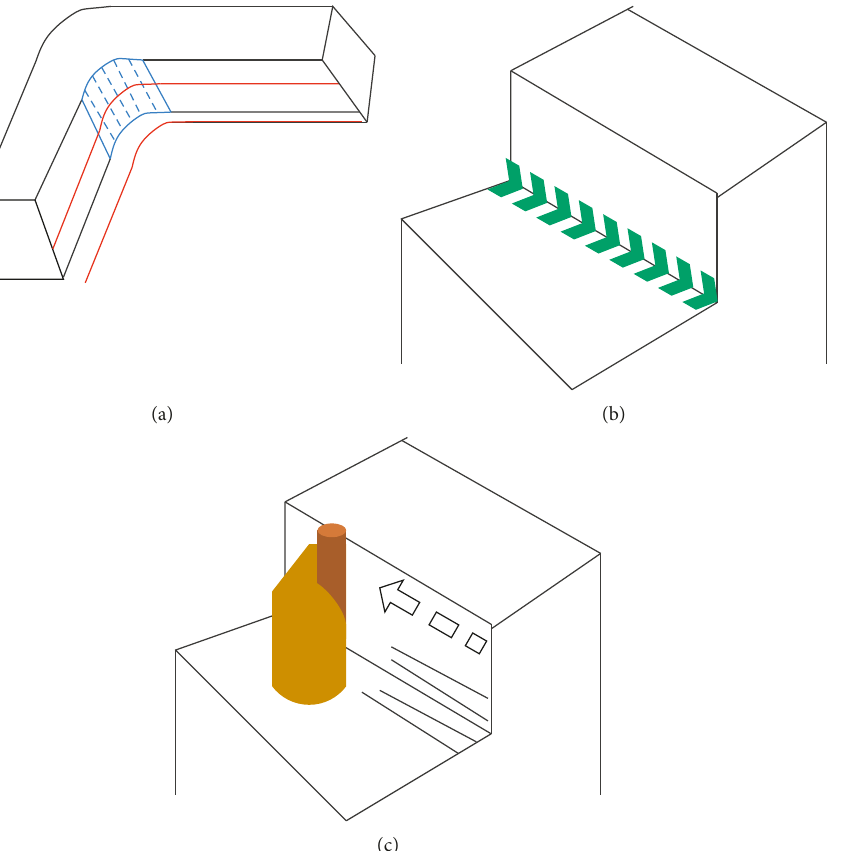
Figure 5: Schematic diagram of pen milling.